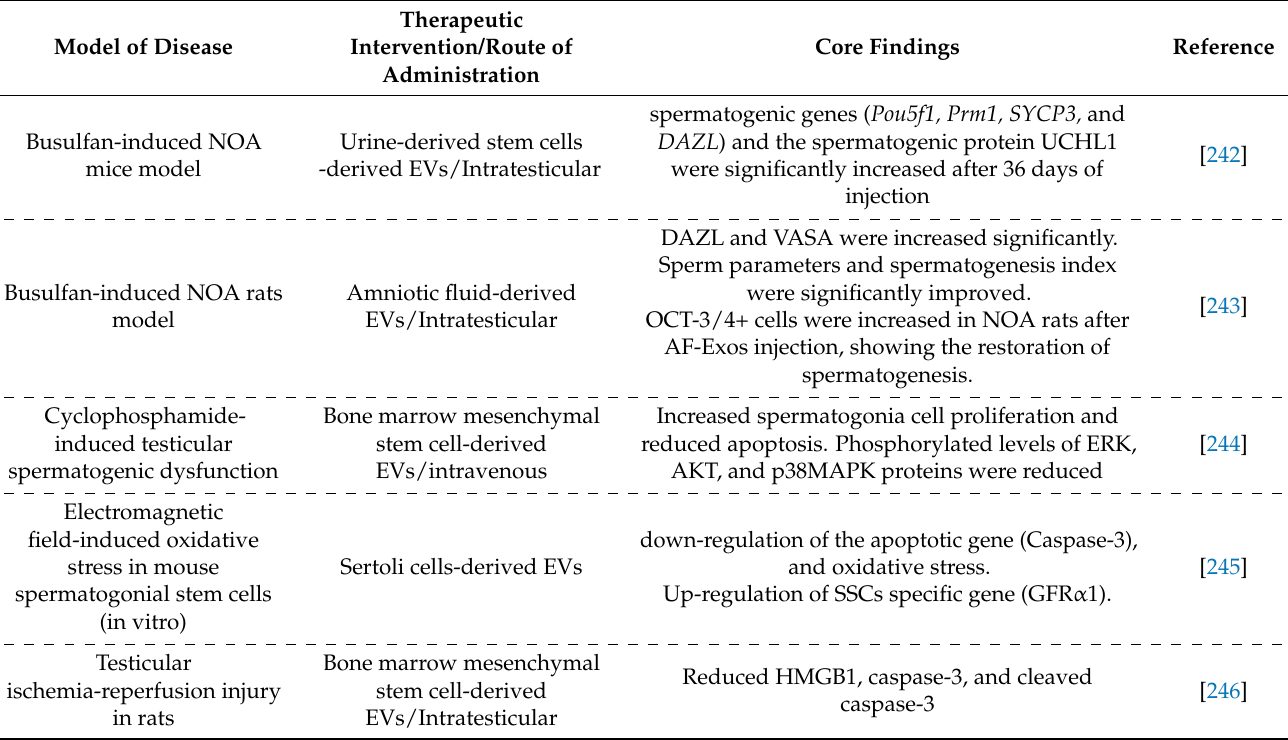
Table 2. Uses of stem cell-derived extracellular vesicles for treating male infertility caused by gonadotoxicity and non- obstructive azoospermia